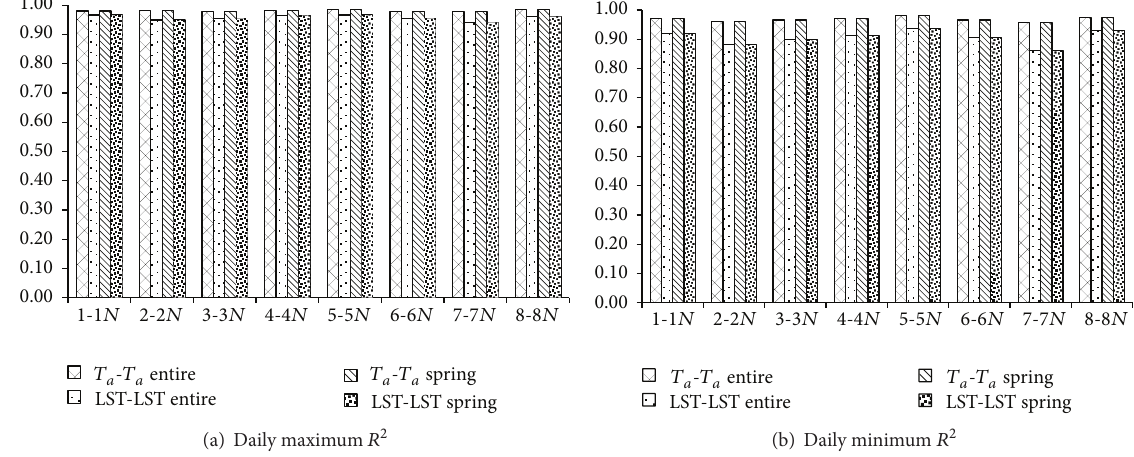
Figure 3: 𝑅 2 values of daily maximum and minimum 𝑇 𝑎 creation results for 𝑇 𝑎 - 𝑇 𝑎 and LST-LST methods. In each group of bars, from left to right are 𝑇 𝑎 - 𝑇 𝑎 (entire period), LST-LST (entire period), 𝑇 𝑎 - 𝑇 𝑎 (spring), and LST-LST (spring).